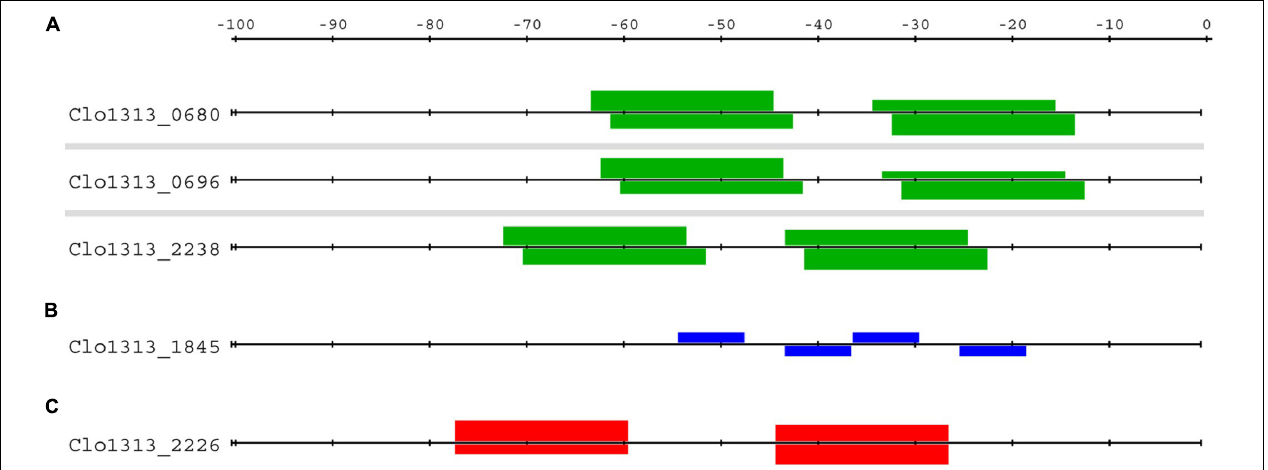
FIGURE 4 | Distribution of BlaI and antitoxin binding sites upstream of target genes. Highly ordered sets of binding sites were found upstream of the putative gene targets of (A) BlaI BlaI_0696, (B) BlaI_1845 and (C) Xre_2225. Each horizontal line represents the sequence upstream of the locus tag on its left. Boxes above or below represent binding sites of the respective TF on the coding or template strand, respectively. The bindings sites for BlaI_0696 (green boxes, A ) and Xre_2225 (red boxes, C ) contain inverted repeats ( Figure 2 ), whereas the BlaI_1845 binding site (blue boxes, B ) contain only a single repeat. The height of the box references the p -value of the binding site, the taller the box the lower the p